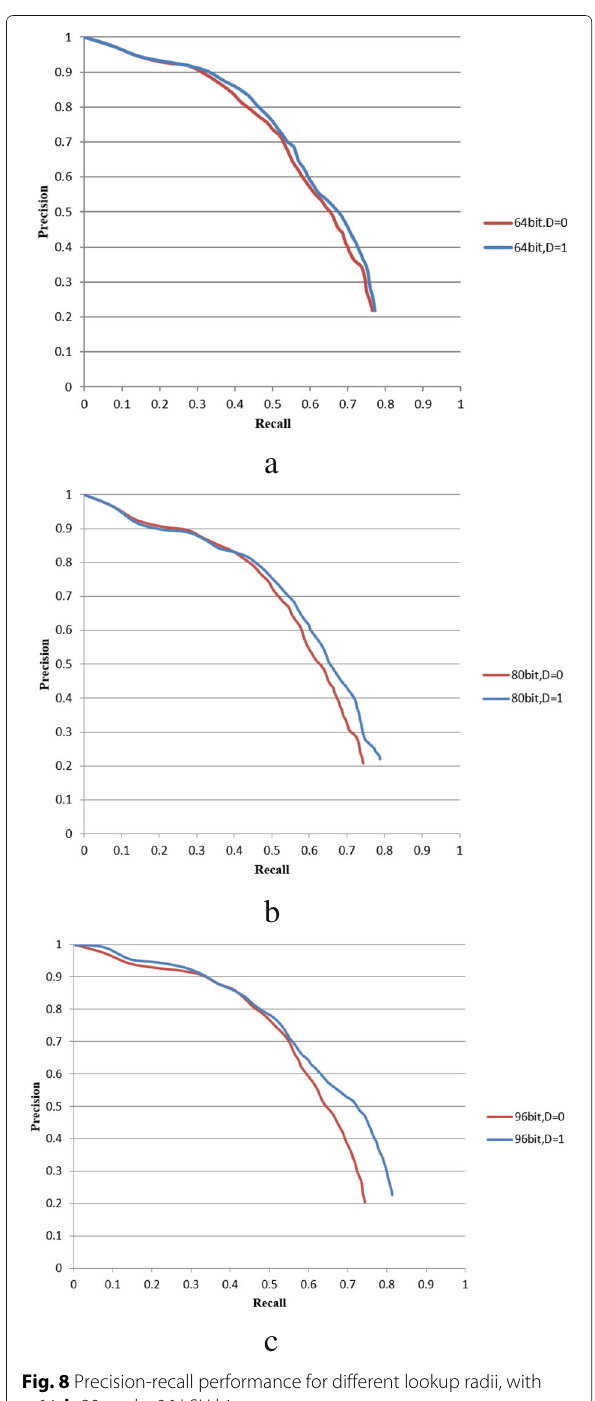
Fig. 8 Precision-recall performance for different lookup radii, with a 64, b 80, and c 96 LSH bits